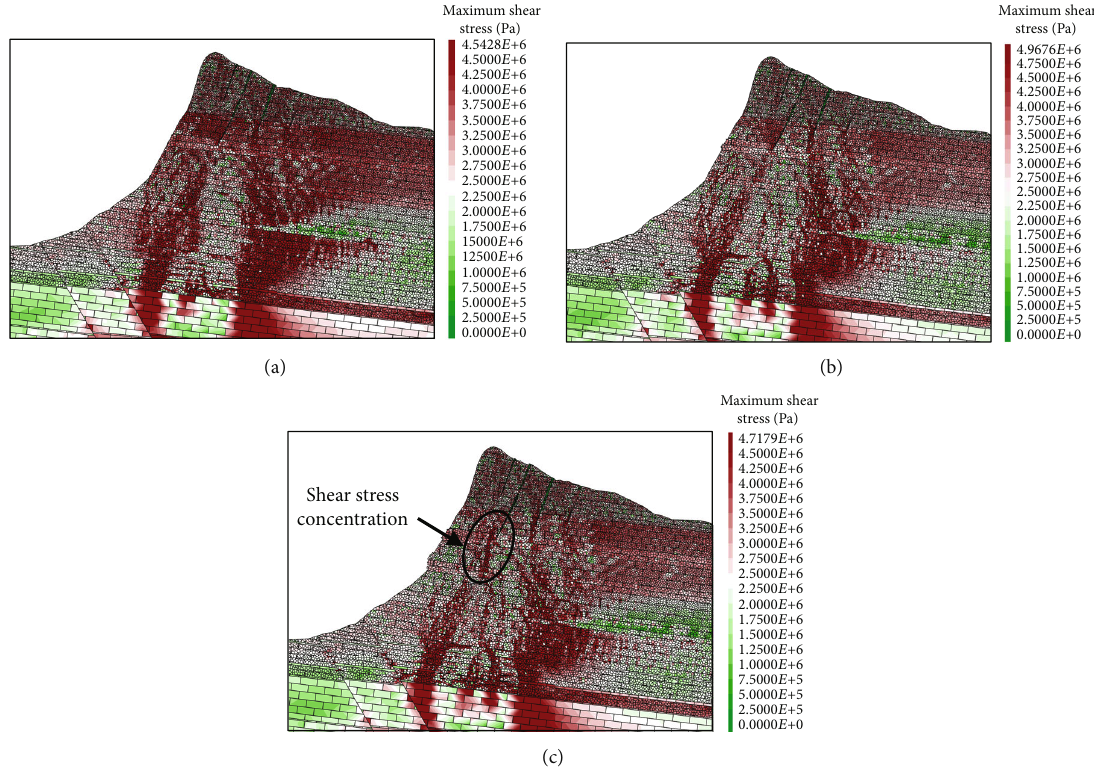
Figure 10: Maximum shear stress cloud map of mining slope: (a) No. 14 coal seam mined out; (b) No. 10 coal seam mined out; (c) after heavy rainfall.